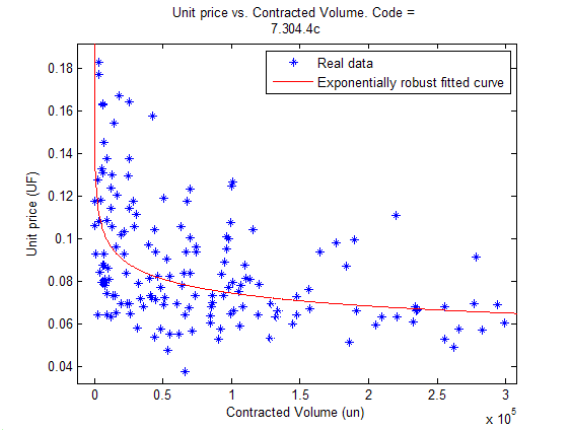
Fig. 6. Fitted curve for 7.304.4c – Asphalt slurry seal